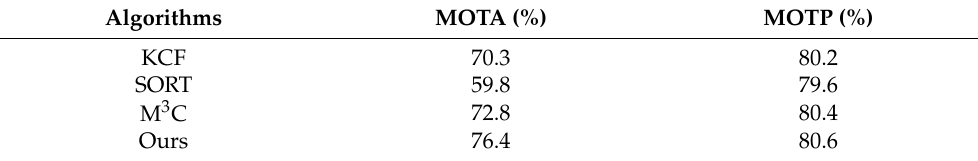
Table 2. Comparison of evaluation indicators of different target detection and tracking